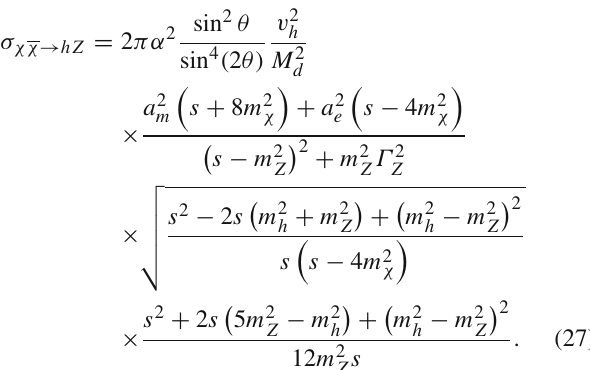
4 m 2 χ . Spin averaging eliminated the cross-multiplication terms between the magnetic and electric dipole couplings in the